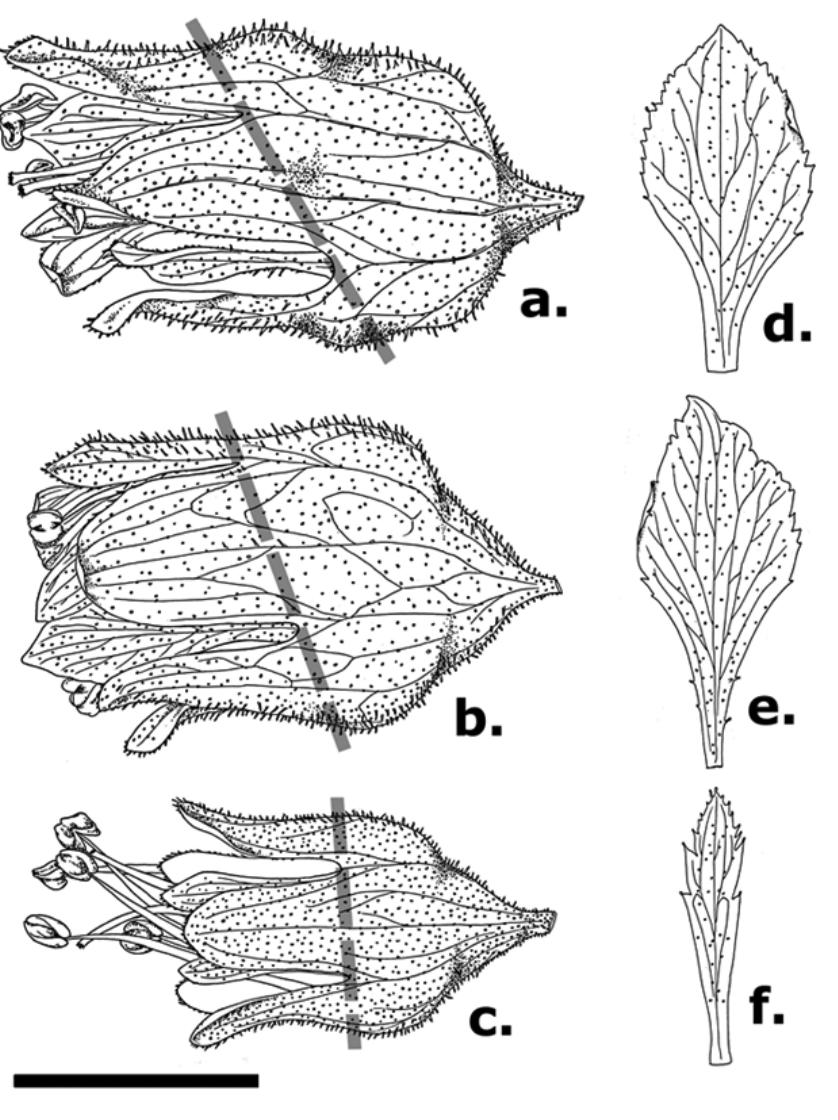
Figure 3. Comparisons of flowers and single petals (adaxial surface) of three Heuchera species co-occur- ring in PA, WV, and VA, based on spirit-preserved materials: Heuchera alba ( a, d North Fork Mountain, WV; Folk 63 [deposited at OS]), Heuchera pubescens ( b, e Rocky Knob Overlook, Blue Ridge Parkway, VA; Folk 100 [deposited at OS]), and unhybridized H. americana (i.e. H. americana var. americana c, f Chestoa Overlook, Blue Ridge Parkway; Folk 92 [deposited at OS]). Dotted gray lines show degree of hypanthium zygomorphy. Both scale bars represent 5 mm; the left-hand scale bar applies to a–c the right- hand bar is for d–f . Illustrations by R.